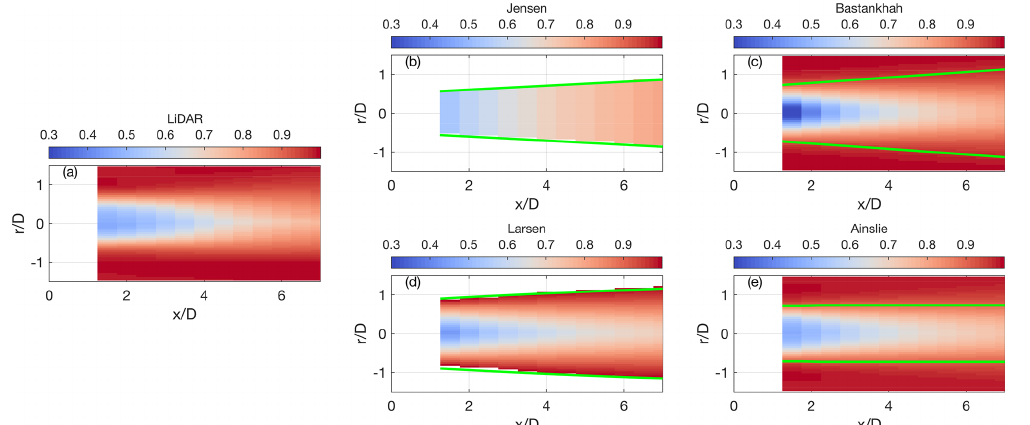
of [0.76, 0.81] and TI of [13.5%, 19.4%]: (a) lidar data, (b) Jensen wake model, Figure 9. Normalized velocity for the cluster with U ∗ hub (c) Bastankhah wake model, (d) Larsen wake model, (d) Ainslie wake model. The green lines represent the wake edges, while for (c) they represent the spanwise position corresponding to 2 σ